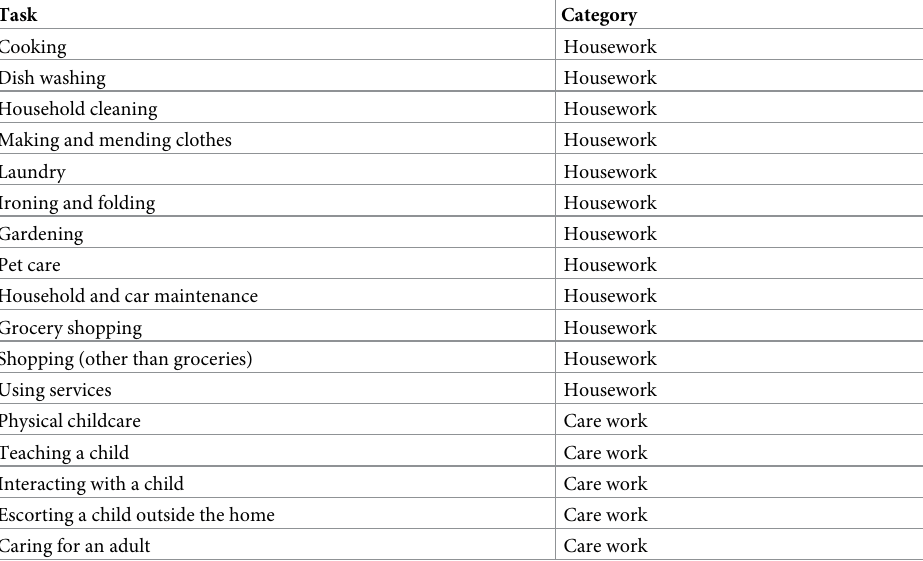
Table 1. Typology of domestic work